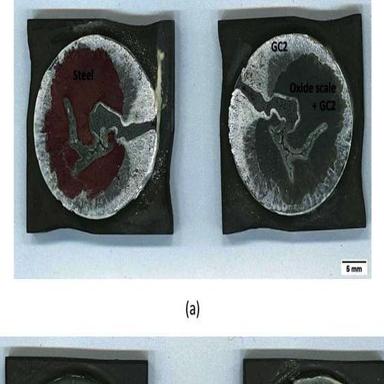
Typical fracture surfaces of both THG-5 and THG-25 joined by GC2 and tested in torsion (FZJ) at 700 °C (a) and 800 °C (b) (pictures refer to THG-25). Typical torque (T, Nmm) versus time (minutes, 4°/min) of a THG-25 joined sample tested at 800 °C (c).